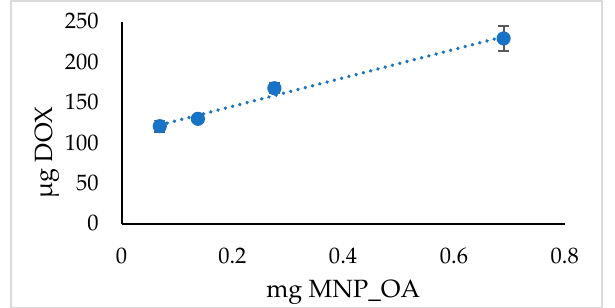
Figure 5. DOX loading MNP_OA capacity.